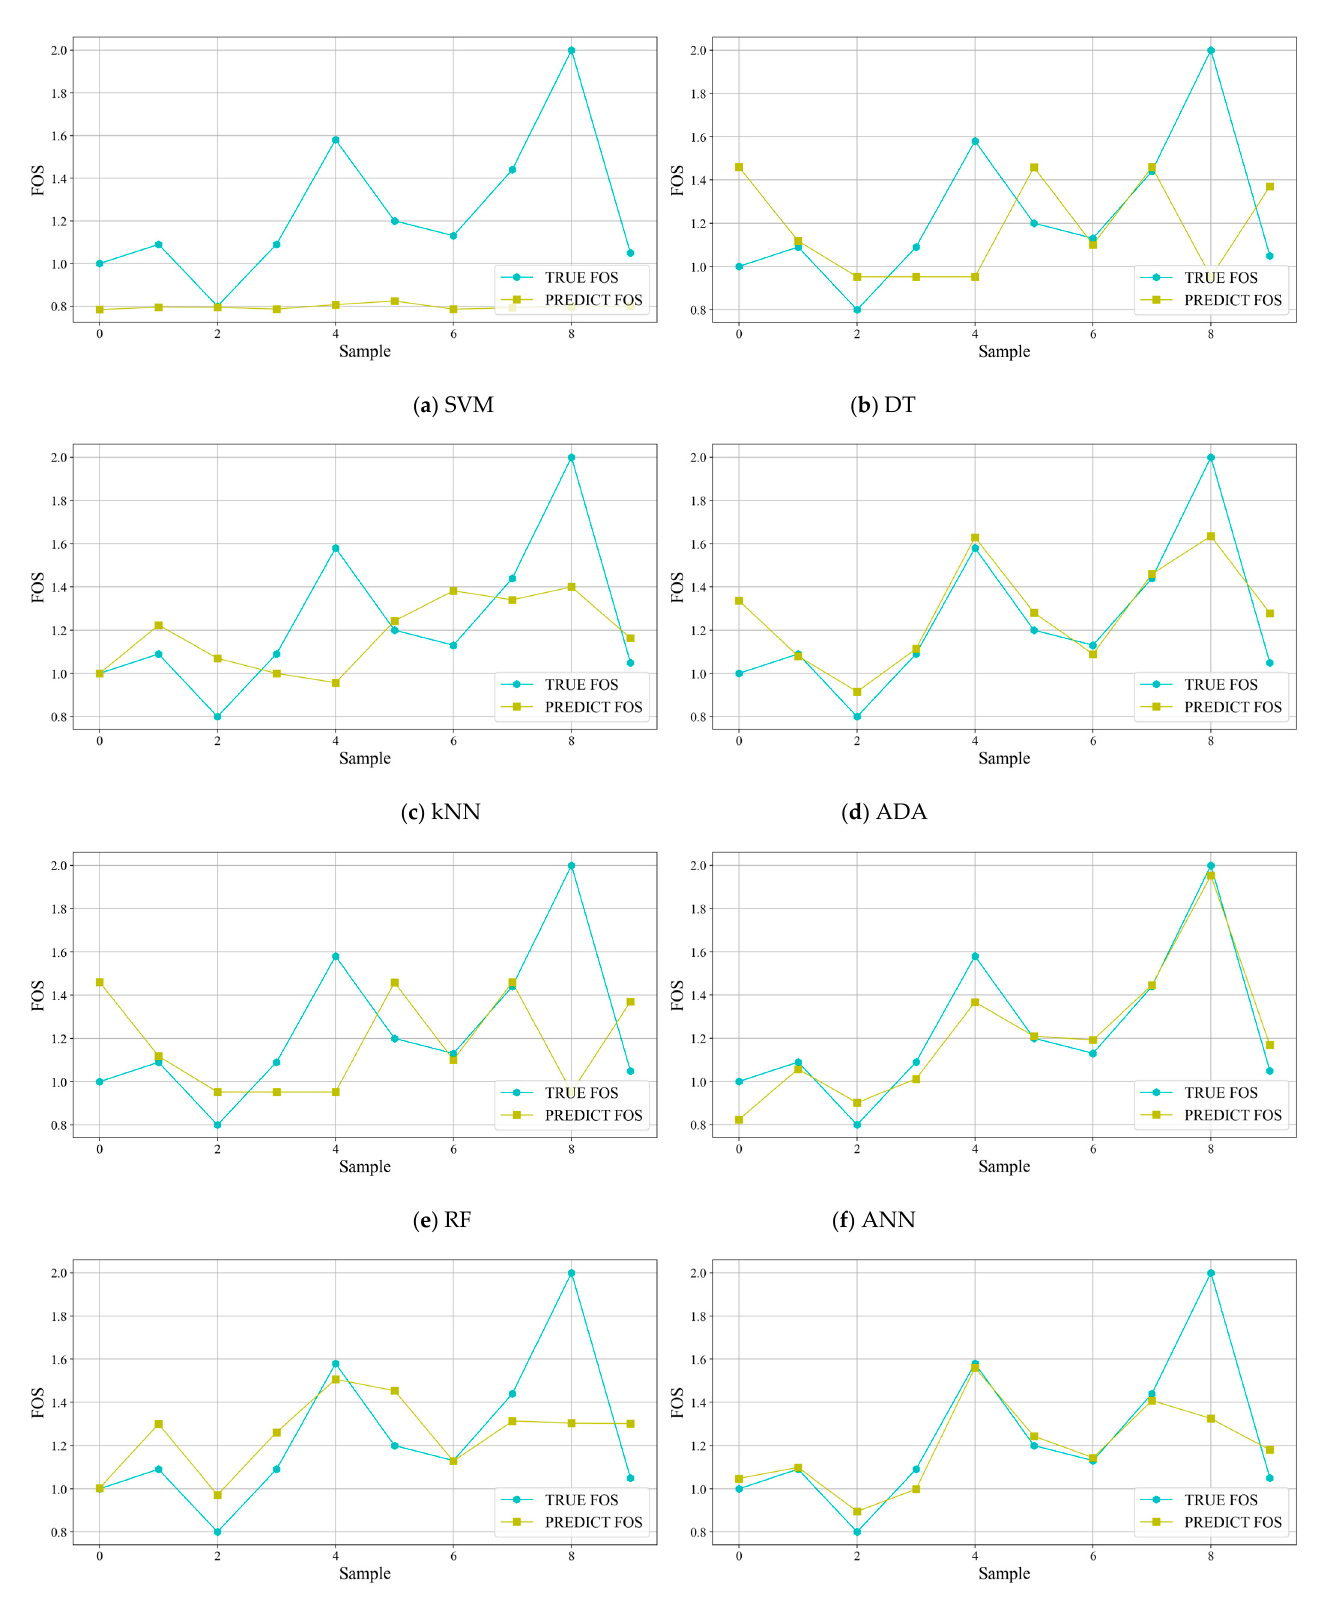
Figure 4. Results of the eight machine learning methods on test set.